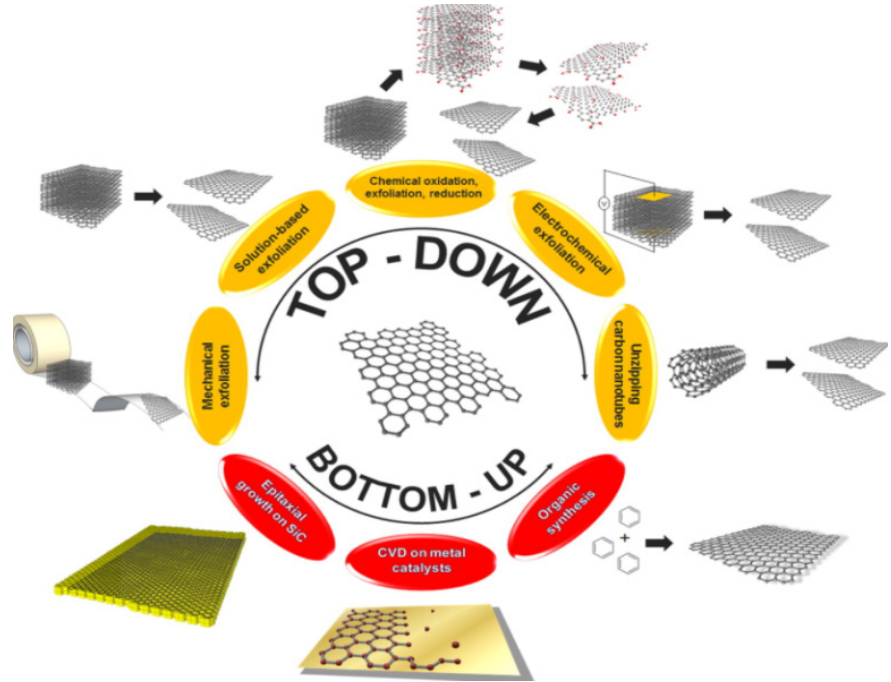
Figure 5. Illustration of different approaches of graphene production. “Reproduced with permission from [63], [New Carbon Materials]; published by Elsevier, 2020”.